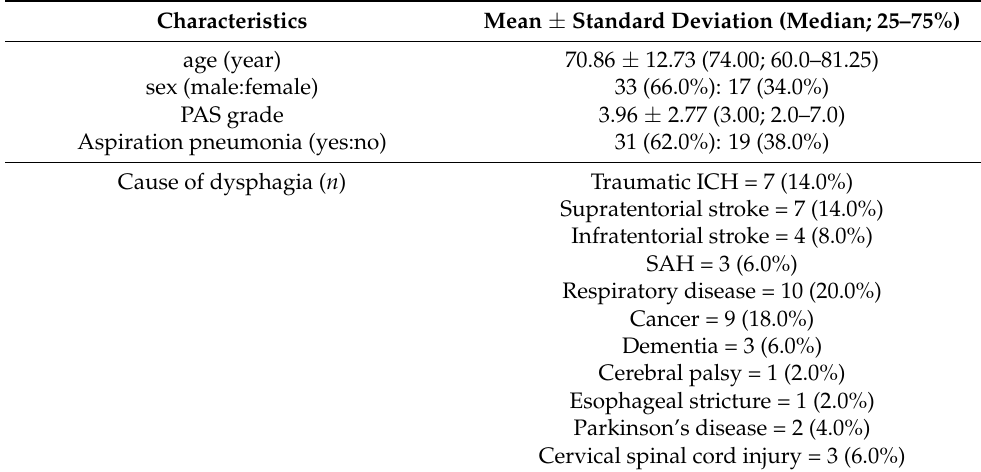
Table 3. Characteristics of patients with dysphagia who included in this